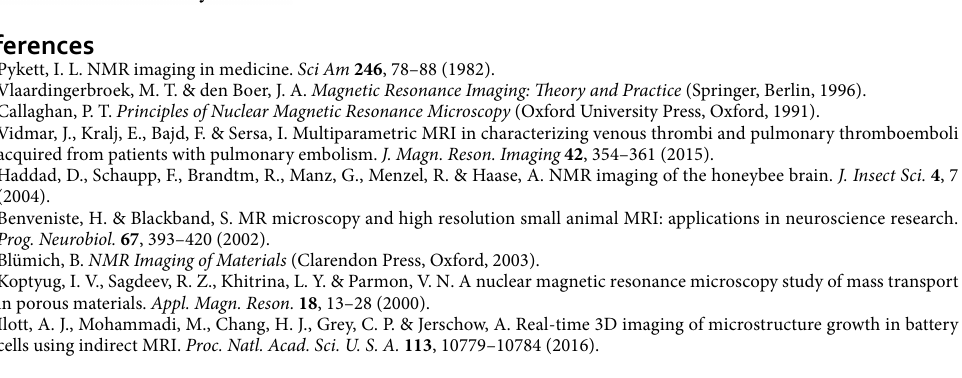
intensity was not directly proportional to the signal and therefore to the moisture content in the tablet, but was elevated due of noise. If the noise level is known, the image intensity can be corrected by compensating the noise contribution. This compensation was done on the radial profiles by the procedure described in Supplementary material (Eqs. S8–S10), so that the corrected radial profiles were proportional to the NMR signal. Corrected profiles of 3D image slices were converted to the radial profiles of gravimetric moisture contents ( MC g ) by mul- tiplying them with the ratio between the tablet’s average MC g (Supplementary Table S2) divided by the tablet’s average corrected voxel intensity. Similarly, the radial profiles of water area density dm / dA , i.e., the mass of water per unit area as a function of radial distance r , was calculated from the corrected radial profile S ( r ) of the 2D tab- let image multiplied by the ratio between the absorbed water mass m , divided by the signal of the tablet (sum of R S ( r ) 2 π r dr . Here R is the radius of the tablet. all corrected pixel intensities of the tablet): dm / dA = S ( r ) m / 0 (cid:31)